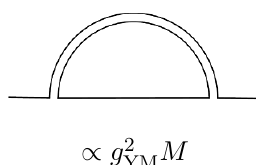
Figure 3 . 1-loop contribution to the real part of the quark